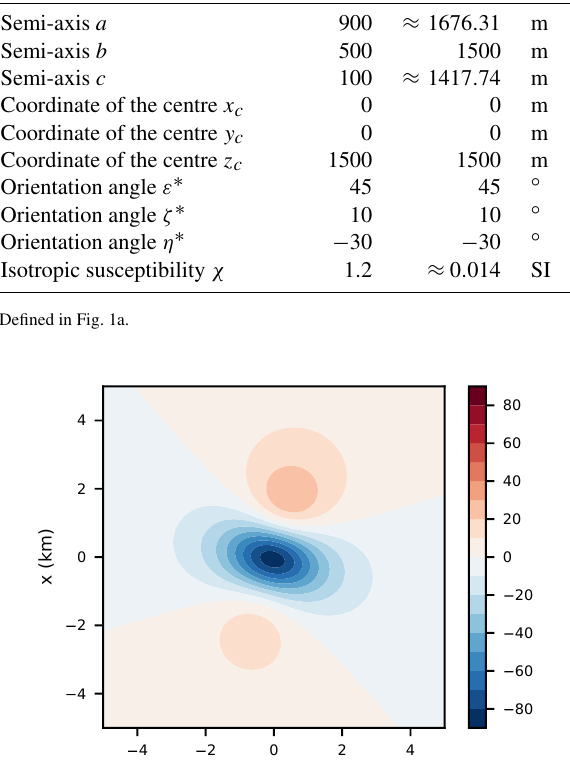
Figure 3. Total-field anomaly (in nT) produced by the synthetic bodies Ellipsoid 1 and Ellipsoid 2, both defined in Table 1. The syn- thetic data produced by these confocal ellipsoids were calculated on a regular grid of 200 × 200 points at the constant vertical coordinate z = 0m. These data were calculated with a uniform inducing field parallel to the semi-axis a of the confocal ellipsoids.